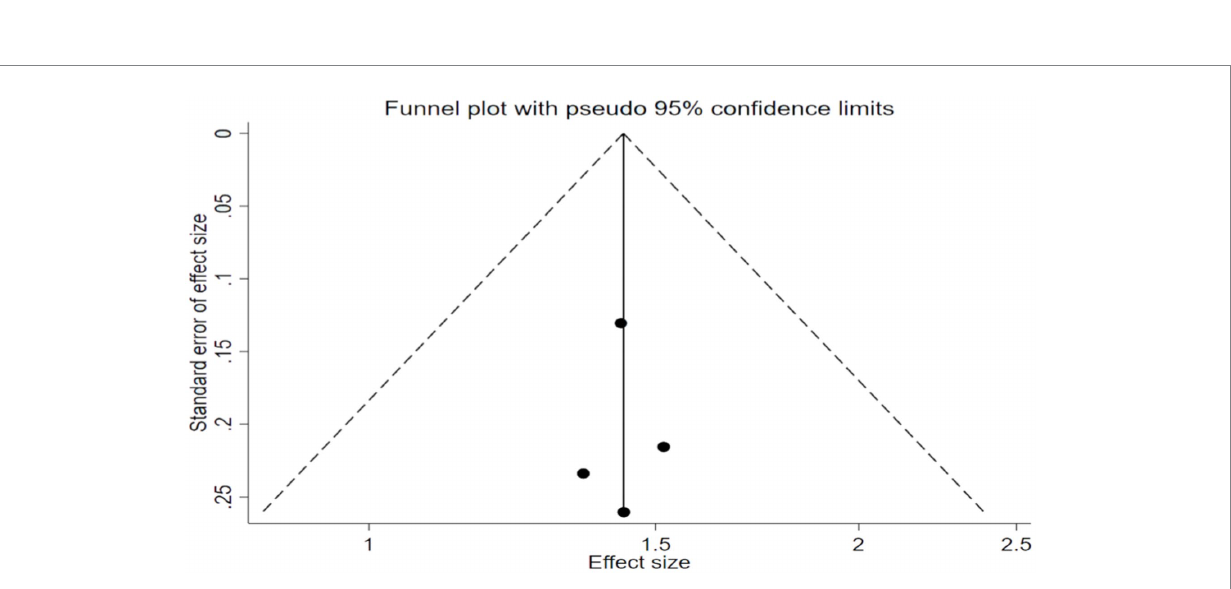
FIGURE 6 Mini-mental state examination scores after traditional Chinese exercises.